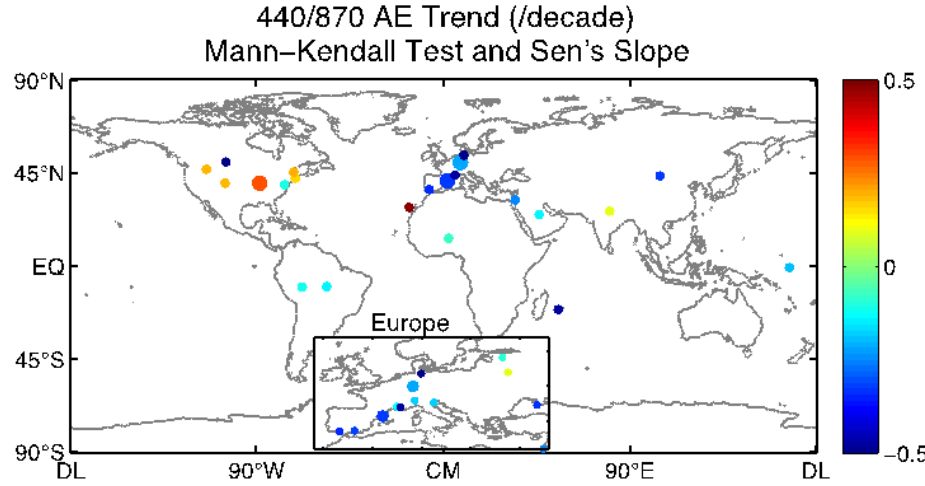
Figure 6. Global map showing the magnitude and significance of the trend in the AE parameter. Only statistically significant ( > 90%) trends are shown. The smaller dots indicate trends at 90% significance, while larger dots indicate trends at 95% significance. The magnitude of the trend (decade − 1 ) is indicated by the color of the dots, following the color scale on the